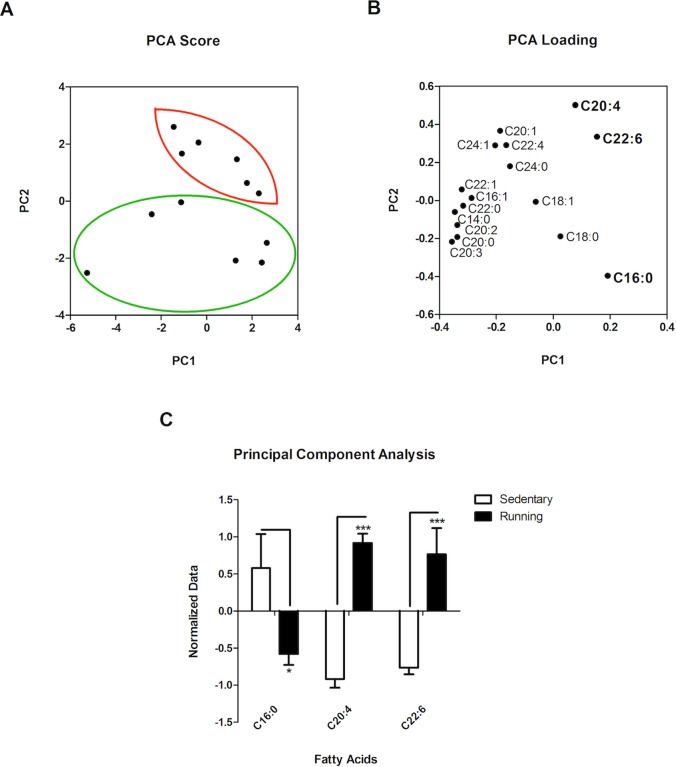
PCA Analysis of GC/MS Data.The cortical nerolipidome raw data normalization at MetaboAnalyst was subjected to PCA variance analysis. A. Variance of the cortical samples showing a clear difference between samples belonging to Running mice (dots within red oval) and their Sedentary counterparts (dots within green oval). B. Variance between the different FA detected in the cortical samples from running and sedentary mice. AA and DHA had the most significant variance showing a significant increase in running mice, compared to sedentary controls. PA also had a significant variance showing decreased levels in running mice. C. Bar graph depicting the differences in PA (*P<0.05), AA (***P<0.001), and DHA (***P<0.001) normalized abundance in sedentary and control mice. Data are expressed as the mean ± SEM.